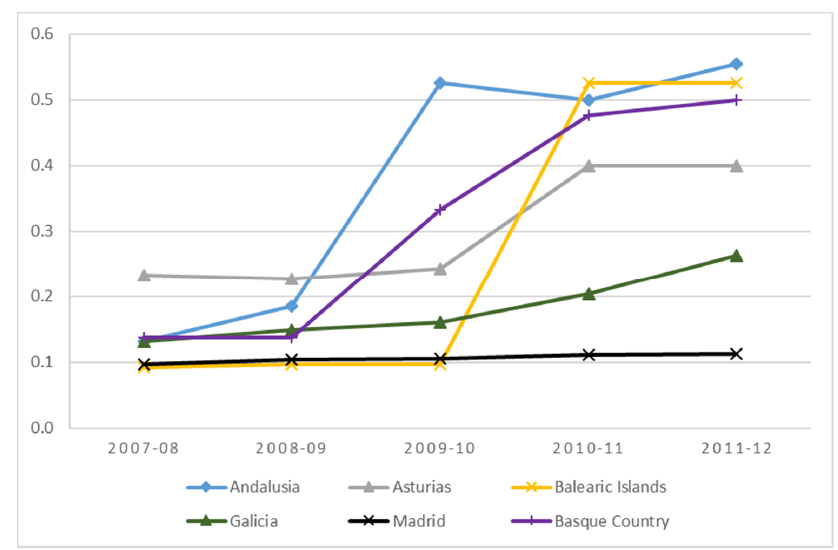
Figure 2. Average number of computers used for teaching per student in public primary schools in regions participating in Escuela 2.0 compared to Madrid. Source: Own elaboration based on data from the Spanish Ministry of Education.